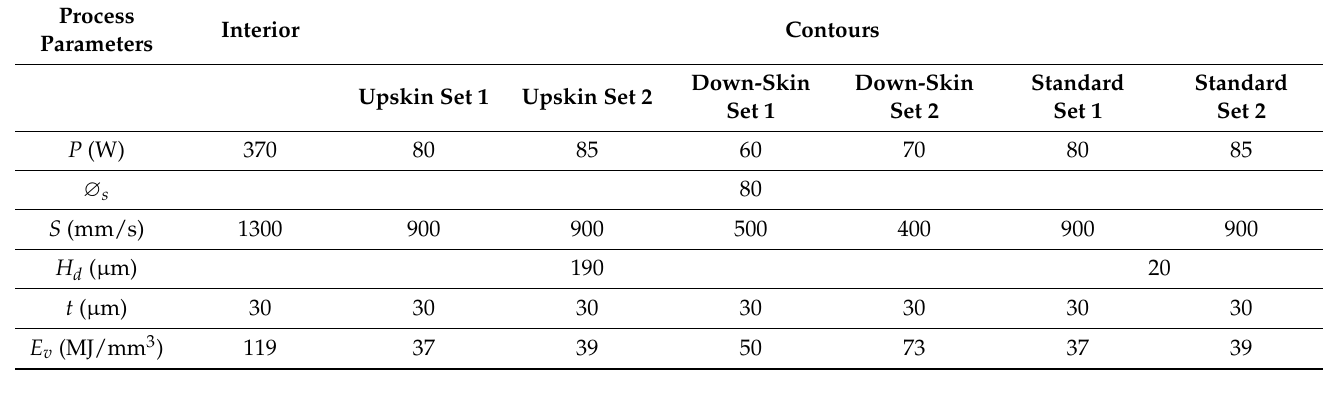
Table 1. Process parameters related to the building strategy and evaluation of the energy density (contour performed in two passes: set 1 and set 2).